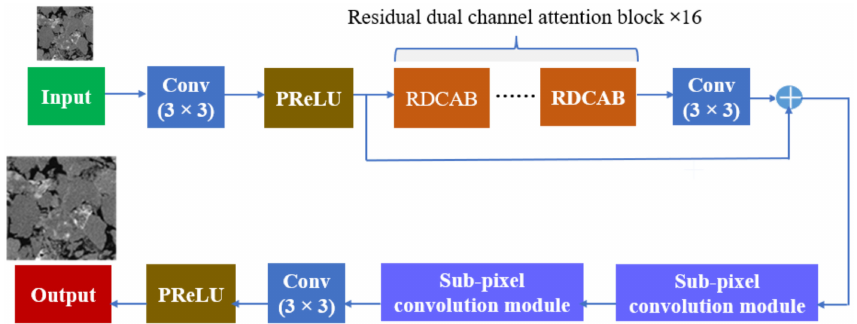
Figure 6. Architecture of the